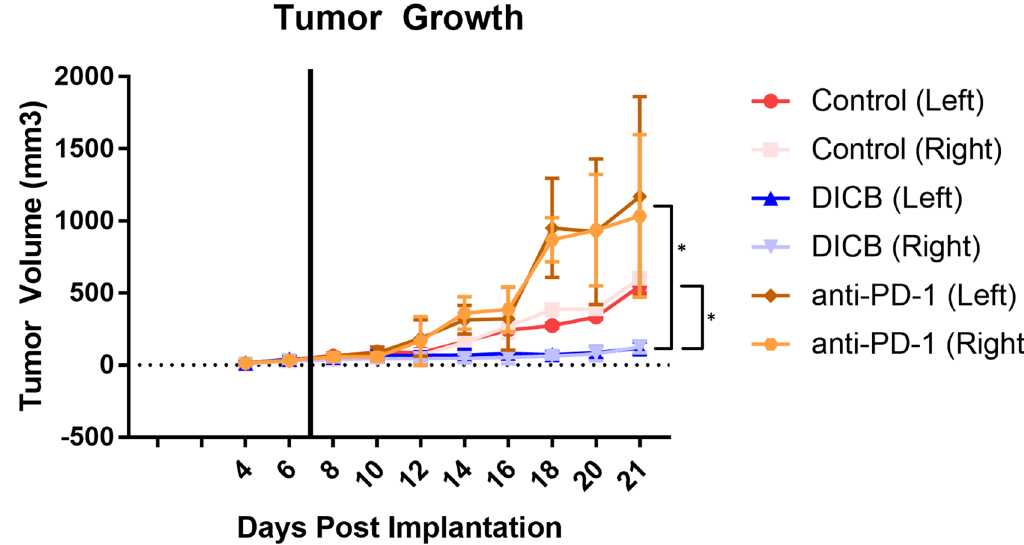
Figure 1. Tumor growth curves for each treatment group, further divided into left sided and right sided tumor growth. The solid black line denotes initiation of treatment. Standard deviation is shown with error bars. Significance of p < 0.05 between treatment groups is denoted with an